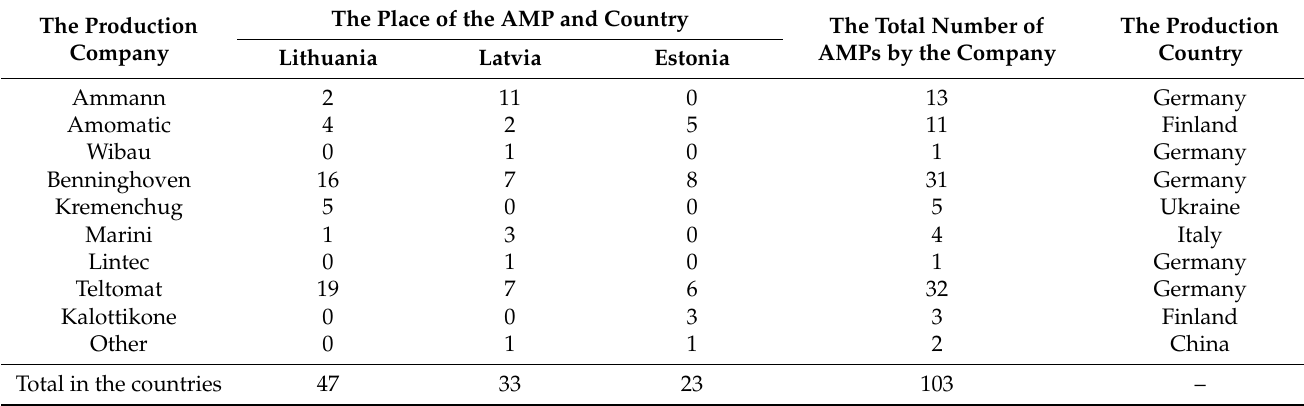
Table 2. The number of AMPs and their manufacturers that operated in the Baltic States in 2017. The Production